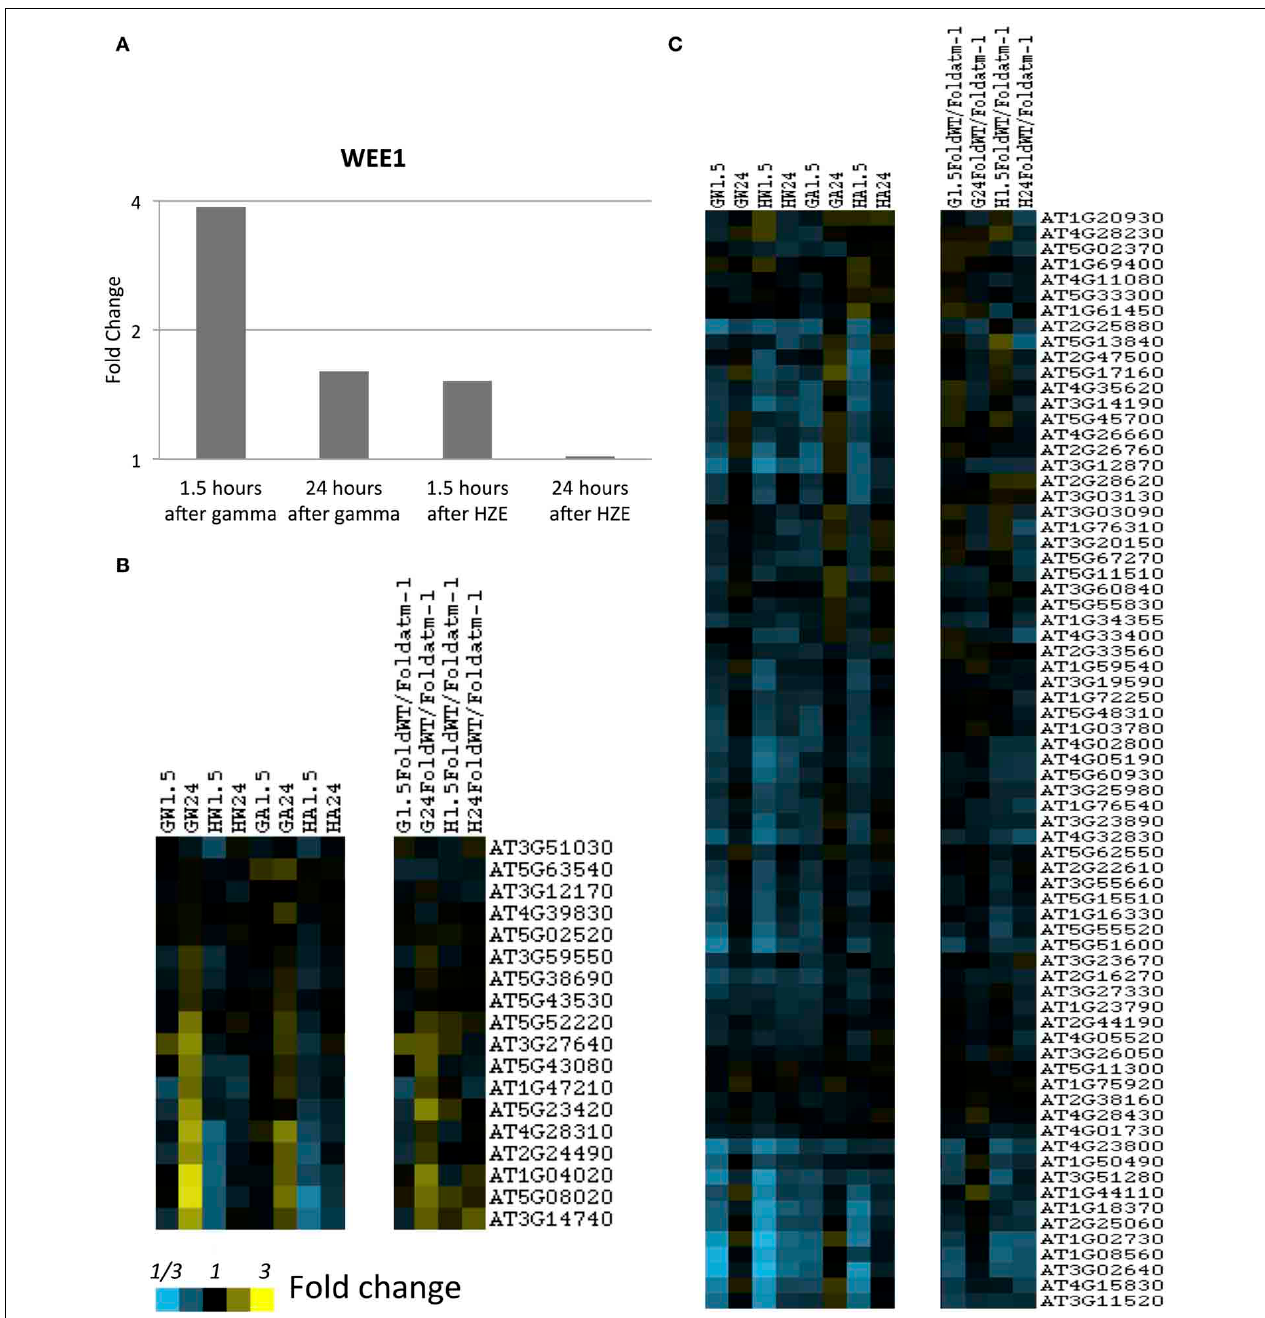
FIGURE 5 | S-and-M-phase-specific transcripts at 1.5 and 24h after gamma or HZE. (A) Fold change of expression of Wee1 was calculated at 1.5 and 24h after IR. Fold-change of expression was also calculated for (B) S-phase specific, or (C) M-phase specific transcripts (Menges et al., 2005) at 1.5 and 24h after gamma radiation in WT (GW1.5 and GW24), 1.5